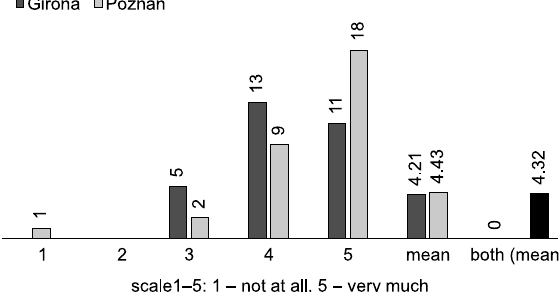
Fig. 2. Students’ satisfaction with the LBD method – the capabilities and expertise of the professors.